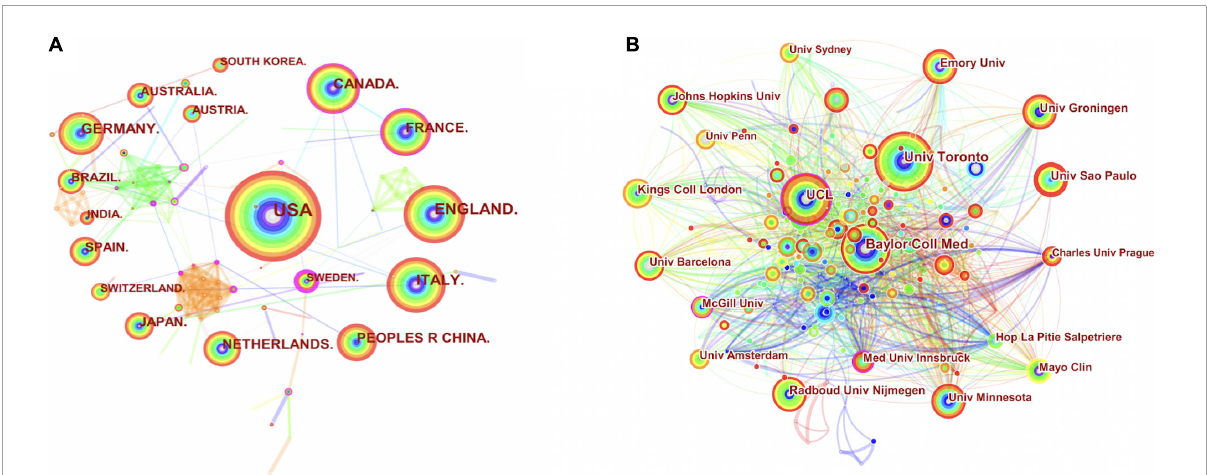
FIGURE2 Annual publication volume of published articles.